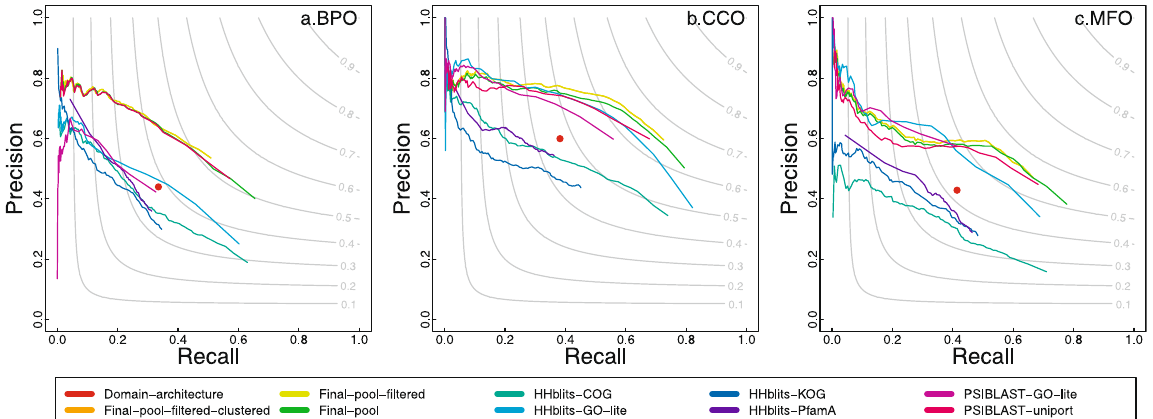
Figure 2. The precision-recall plot of PANDA and other predictors with the lines indicating the values of area under the curve . The predicted GO terms and the real GO terms are propagated to the root in the directed acyclic graph. It can be found that by combining the baseline predictors, PANDA’s Final-pool-filtered step achieves the highest area under the curve. Notice that the line of Final-pool-filtered-clustered, which is integrated in PANDA’s server, is overlapping with Final-pool-filtered because the second round of filtering after clustering (Final-pool-filtered-clustered) is not removing more GO terms. Most of the low-quality GO terms have already been filtered out by the first round of filtering